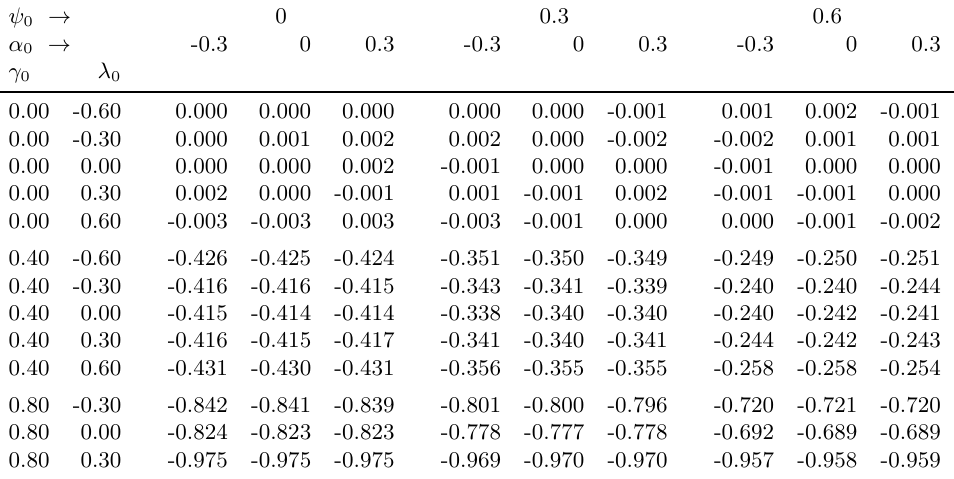
Table D.6: Bias of Team Spatial – marginal direct long-run effect.